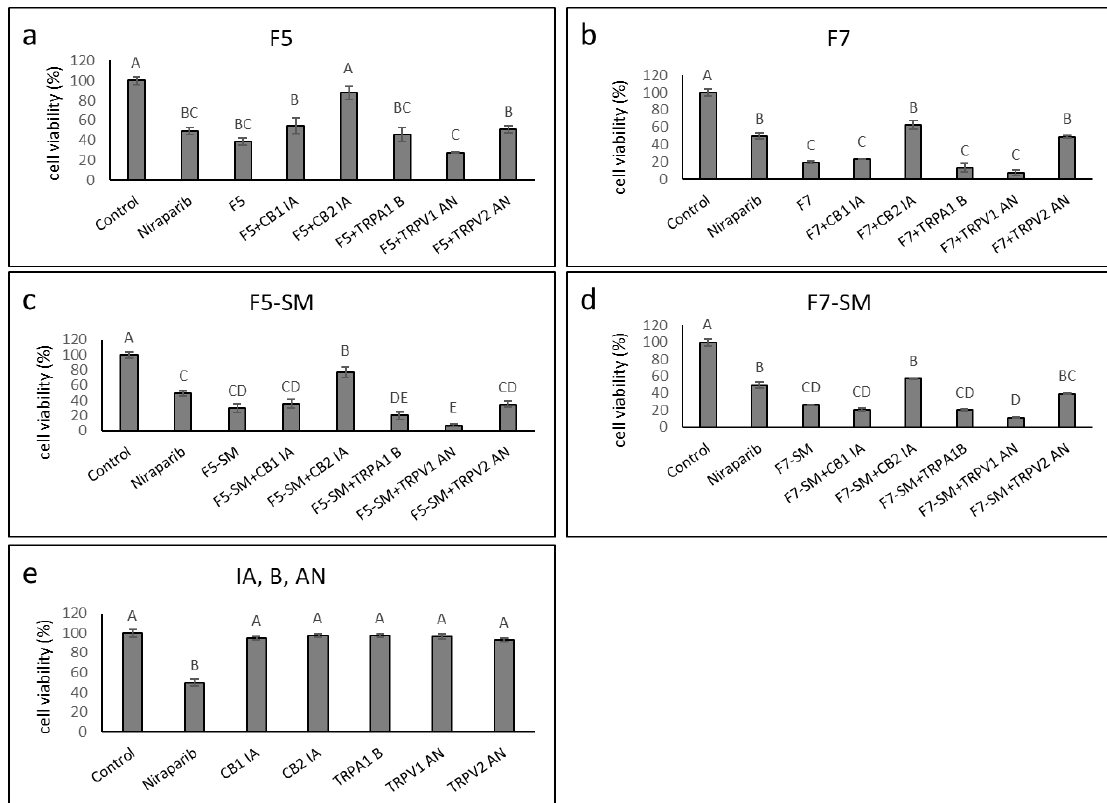
Figure 6. Cell viability of HTB75 cells following treatment with F5 ( a ), F7 ( b ), F5-SM ( c ) or F7-SM ( d ), with or without CB1 and CB2 inverse agonists (IA), a TRPA1 blocker (B), and TRPV1 or TRPV2 antagonists (AN) for 48 h. Cells were treated with F5 (19.1 µg/mL), F7 (19.4 µg/mL), F5-SM (14.7 µg/mL) or F7-SM (13.6 µg/mL), with or without the receptor IA, B or AN (10 µM). ( e ) The effects of IA, B or AN on viability of cells. Cell viability was determined by XTT assay at 48 h as a function of live cell number. Niraparib (6 µg/mL) served as a positive control. Control was vehicle control (1.47% v/v methanol + 1.00% v/v DMSO). Error bars indicate ± SE ( n = 3). Levels with different Upper case letters were significantly different from all combinations of pairs according to the Tukey–Kramer honest significant difference (HSD; p ≤ 0.05).